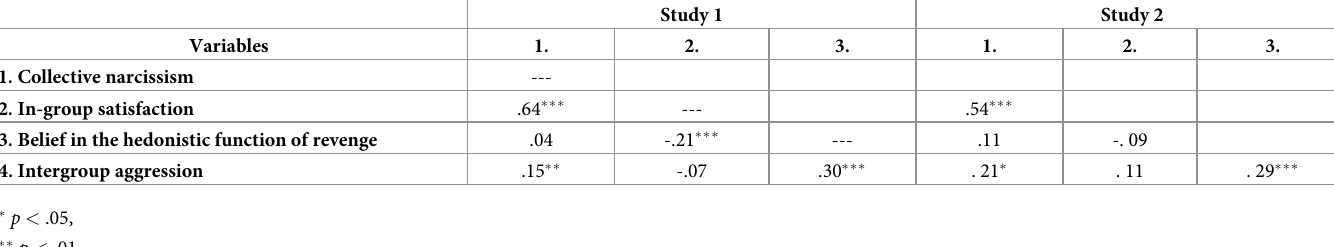
Table 1. Zero-order correlations among variables in Studies 1 and